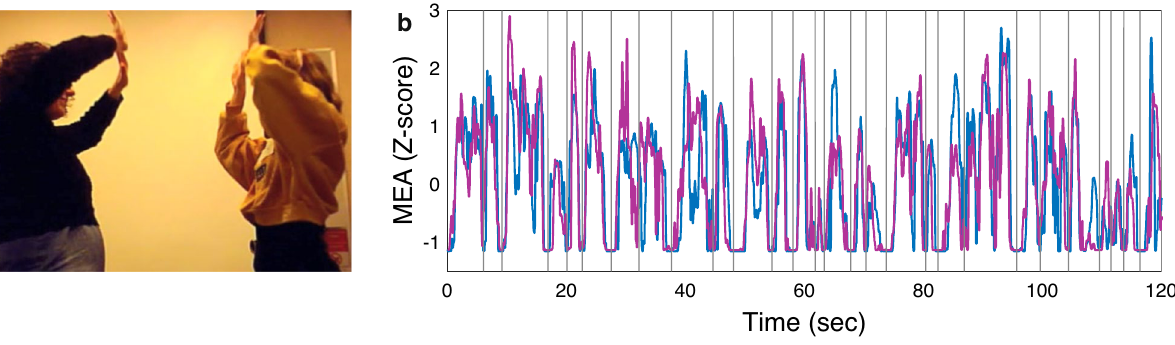
Figure 1. The Mirror Game. ( a ) A pair playing the Mirror Game while a hidden camera alarm clock, that was placed on a table next to the players, is filming the game. ( b ) The Z-scored MEA signals of two representative participants while playing with each other. The vertical lines denote the separation between the movement